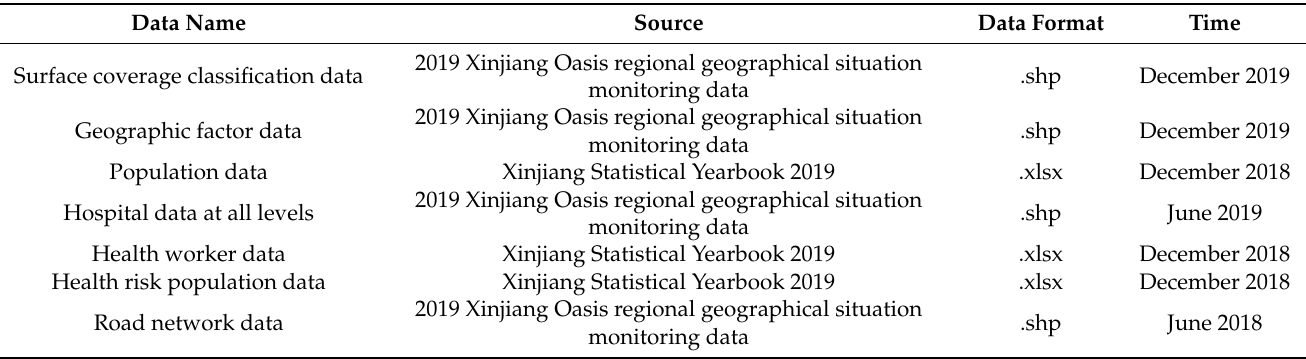
Table 1. Data adopted